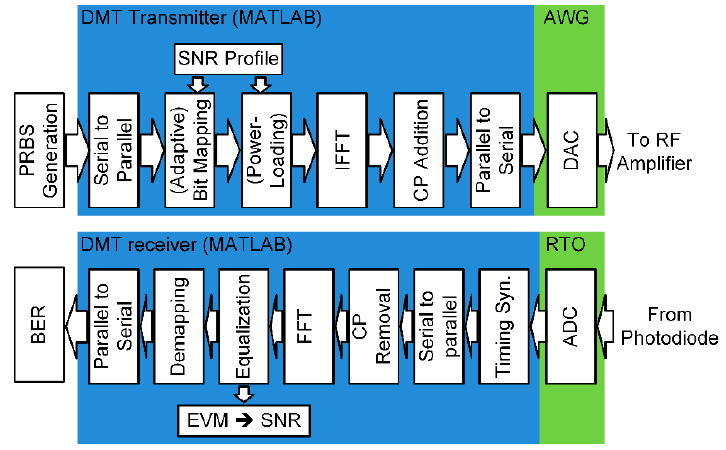
Figure 2. Discrete multi-tone (DMT) signal generation and reception flowchart. A pseudorandom bit sequence (PRBS) is generated, which is then rearranged into a parallel bit-stream. Subsequently, adaptive bit mapping and power-loading are implemented. Inverse fast Fourier transform (IFFT) is then used to encode the quadrature amplitude modulation (QAM) symbols on the DMT subcarriers. Cyclic prefix (CP) is added on the DMT symbols before the signal is converted back to serial. The serial data is loaded onto an arbitrary waveform generator (AWG) which converts the digital signal to analog using an inbuilt digital to analog converter (DAC). On the receiver side the signal is detected by a photodiode and sampled by a real-time oscilloscope (RTO).Next, timing synchronization is performed to recover the DMT clock. Then the serial signal is converted into a parallel data stream. After CP removal, FFT is used to decode the DMT subcarriers. Frequency and phase equalization of the received QAM symbols is performed. Here, we measure the error vector magnitude (EVM) and signal-to-noise ratio (SNR). Then, the symbols on each subcarrier are demapped to recover the transmitted PRBS for bit error ratio (BER)